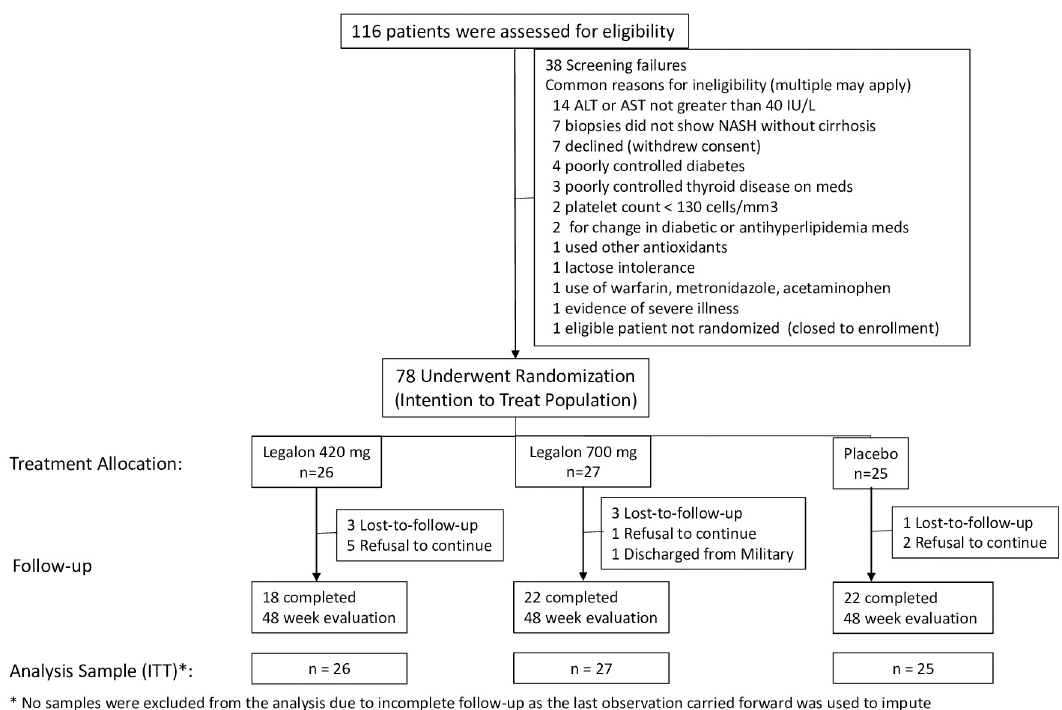
Fig 1. Displayed is patient enrollment. Of the 116 patients assessed for eligibility, 38 failed screening, and 78 underwent randomization (25 to Placebo, 26 to 420 mg, and 27 to 700 mg); this group comprised the intention to treat study population. Twenty-nine of the 78 randomized patients actually met histological criteria for NASH, as determined by the study pathologist (BB). Specifically, 34 biopsies showed an NAS < 4 or no NASH; 1 showed NASH with cirrhosis; and 14 biopsies were either unavailable or not evaluable. Therefore, a subgroup analysis was conducted on the 29 patients, referred to as the intended target population.